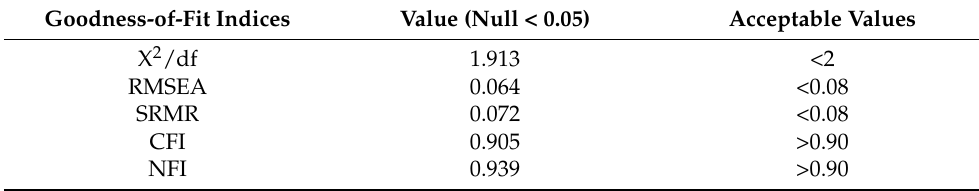
Table 5. Goodness of model fit